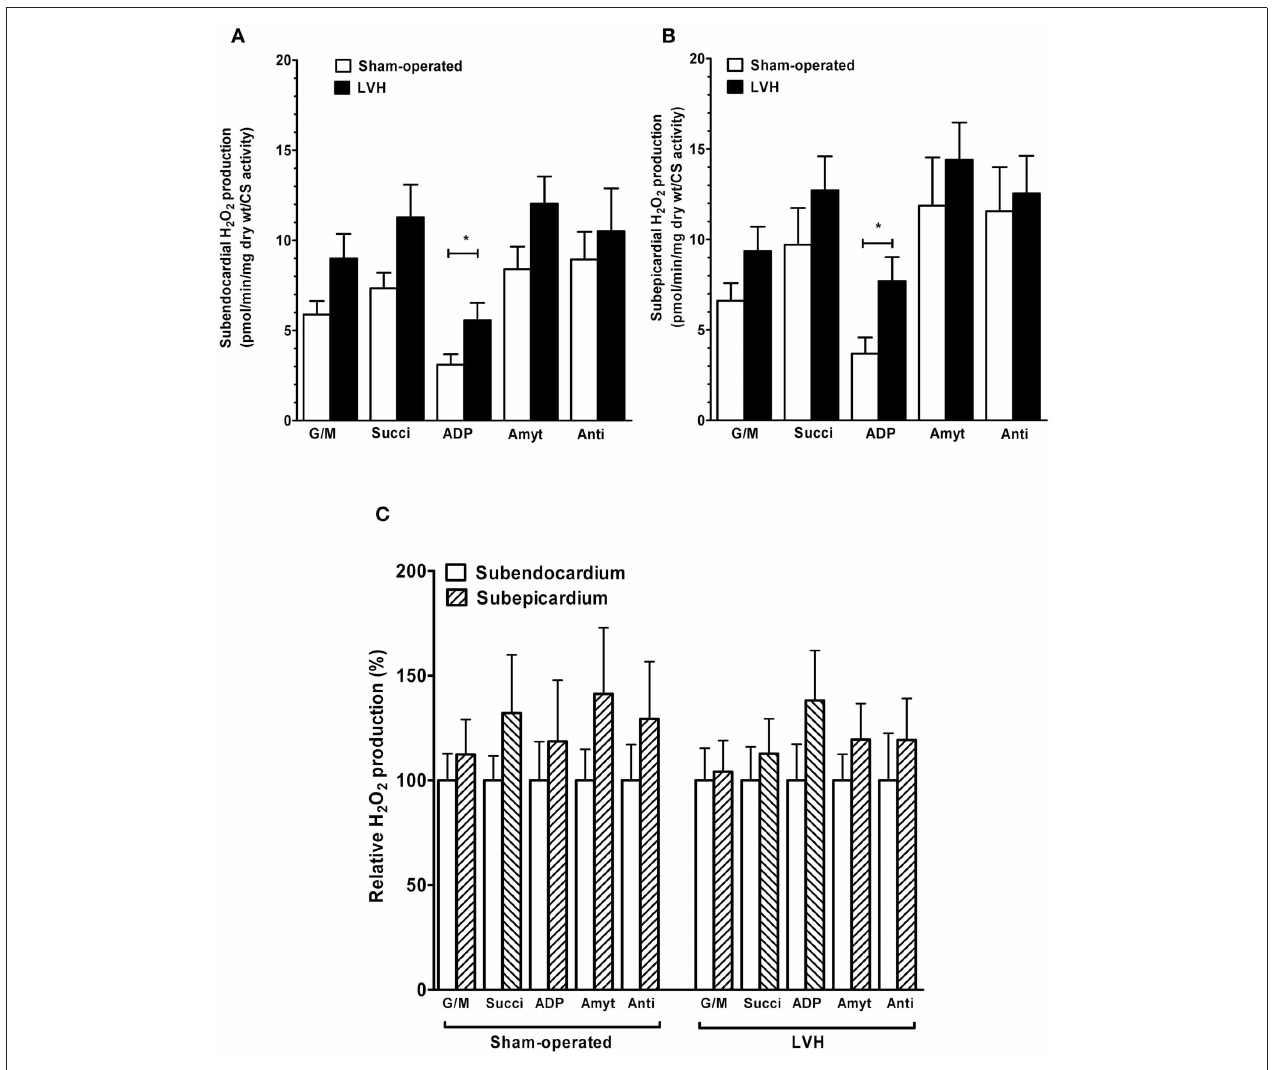
sequentially added. G/M, glutamate and malate are complex I substrates; Succi, succinate is complex II substrate; ADP, adenosine diphosphate is ATP synthase substrate; Amyt, amytal is a complex I inhibitor and Anti, antimycin A is a complex III inhibitor. Values are means ± S.E.M. ∗ , P < 0 .